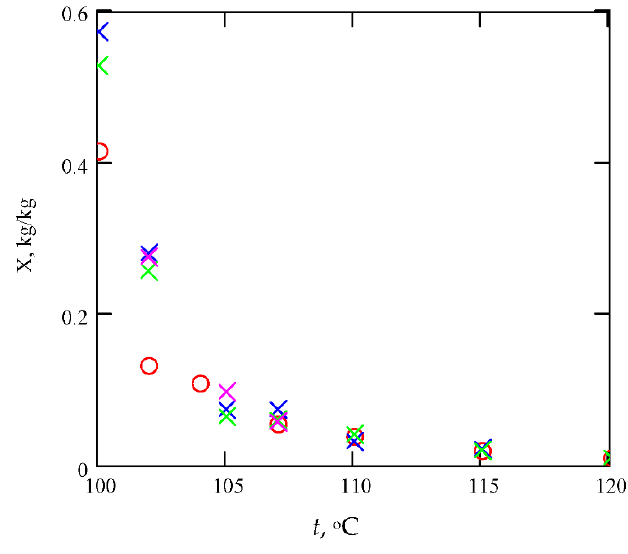
Figure 3. Sorption isobars for cut tobacco lamina (x) and stem (o).